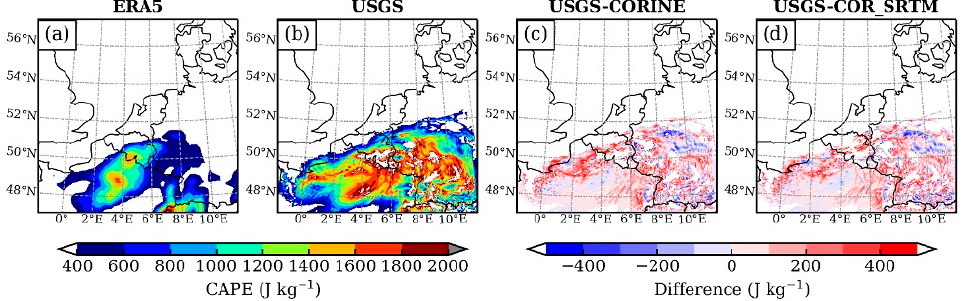
Figure 10. Comparison of CAPE from ( a )ERA5, ( b ) USGS, ( c ) Corine and ( d ) Corine + SRTM at 12 UTC on 18 August 2011.